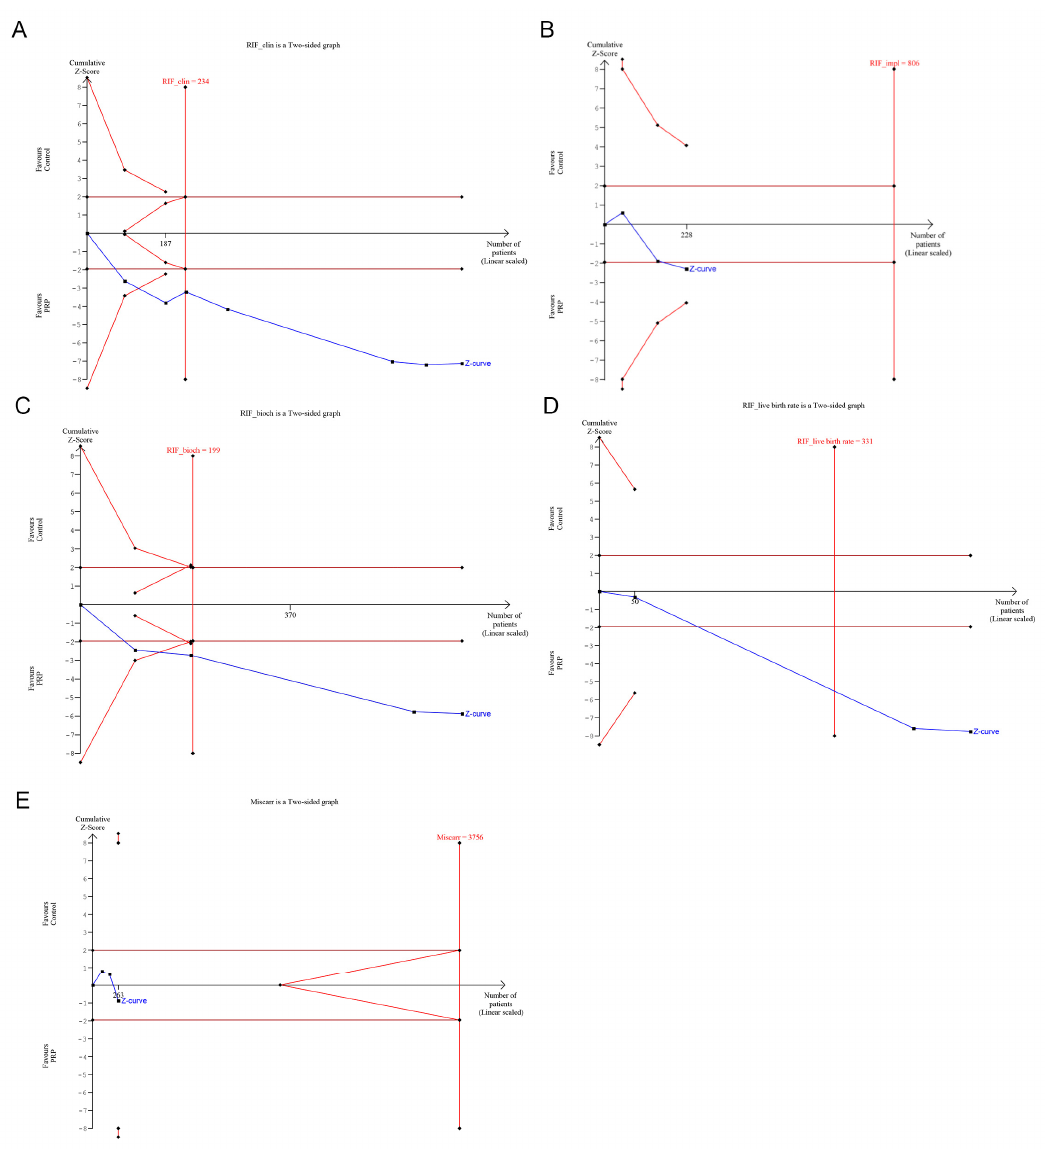
Figure 4. Trial sequential analysis for ( A ) clinical pregnancy rate, ( B ) implantation pregnancy rate, ( C ) biochemical pregnancy rate, ( D ) live birth rate and ( E ) miscarriage rate in recurrent implantation failure (RIF) studies. Studies with high-risk bias were excluded.